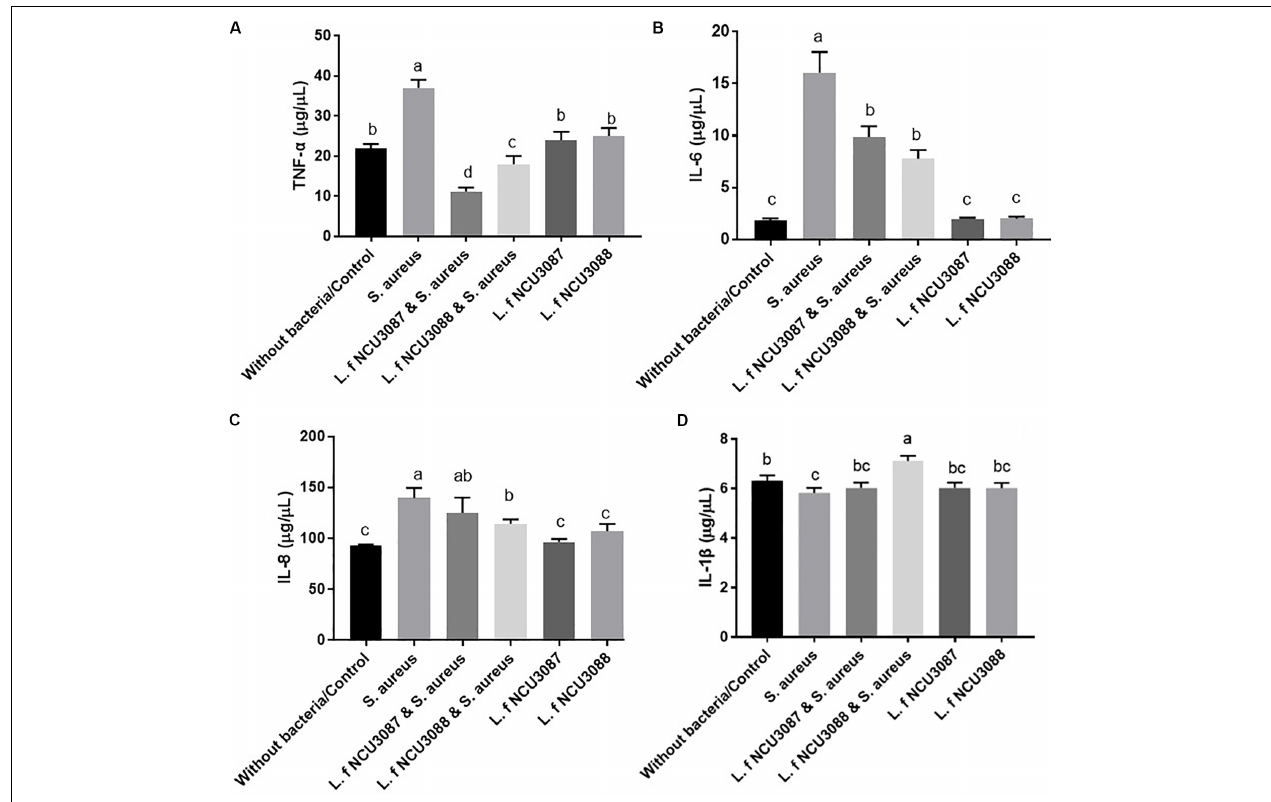
FIGURE 4 | Quantification of TNF- α (A) , IL-6 (B) , IL-8 (C) , and IL-1 β (D) of Caco-2 cells treated by bacteria via ELISA assay. Different letters indicate statistically significant differences between variables.